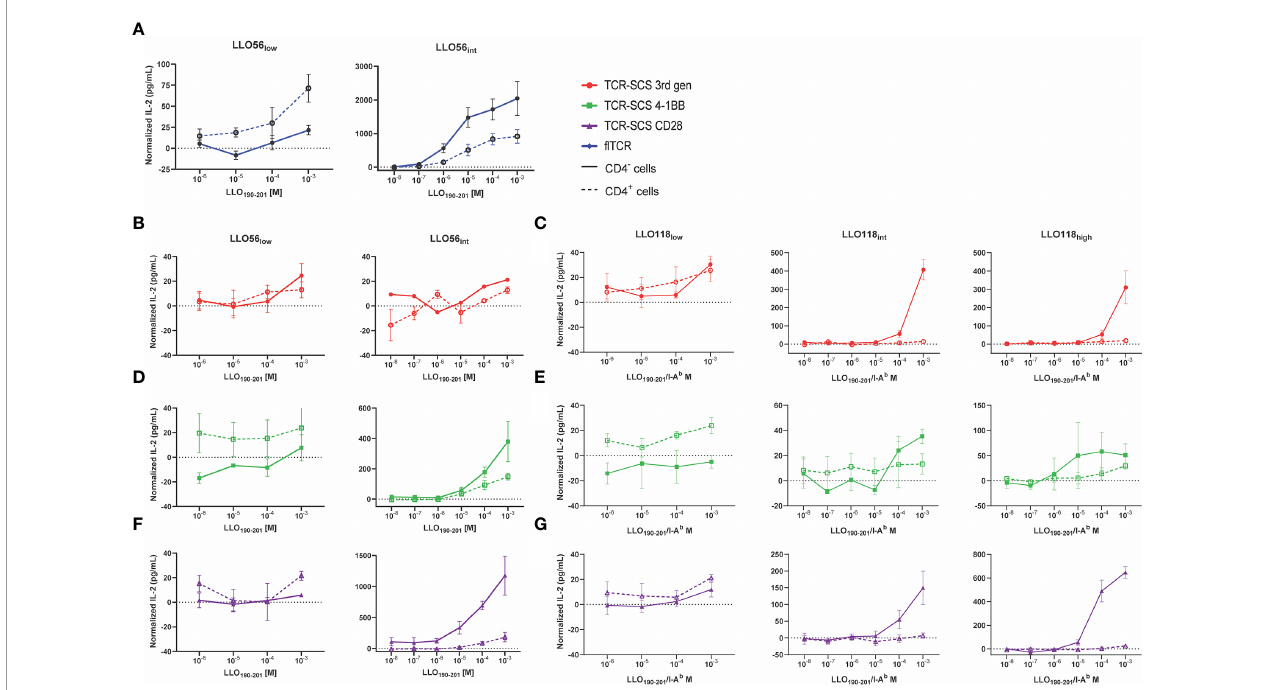
FIGURE 5 | CD4 inhibits IL-2 production of intermediate and high af fi nity TCRs. CD4 - (solid lines) and CD4 + (dotted lines) T cell hybridoma cell lines were incubated with various concentrations of LLO 190-201 peptide (10 -8 M to 10 -3 M) presented by BL6/C57 splenocytes for 24 h. IL-2 production was measured by ELISA. Each sample was normalized by subtracting baseline IL-2 production from T cell hybridoma/splenocytes controls incubated without peptide. (A) LLO56 fl TCRs, (B)